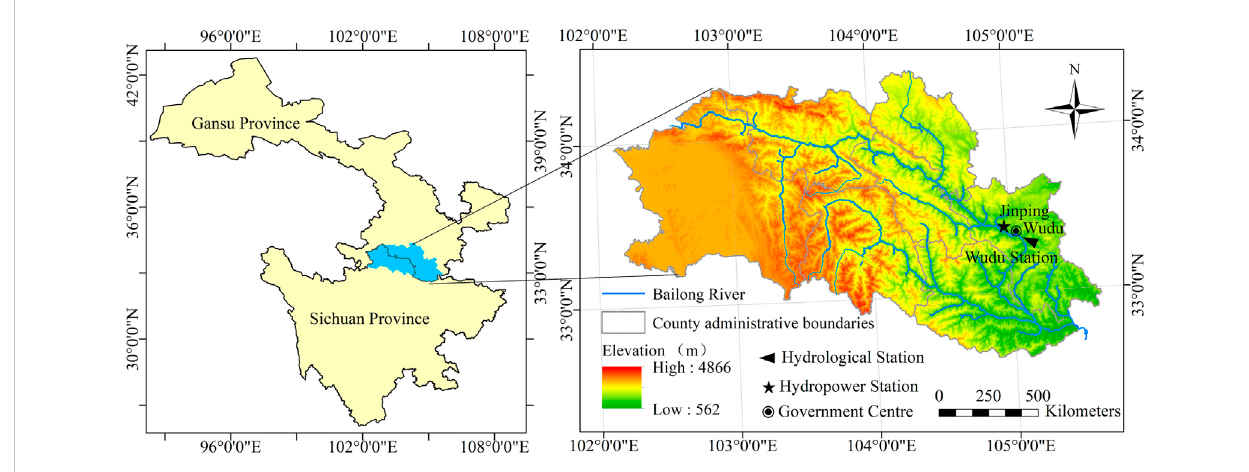
FIGURE 1 Overview of the water system and hydrological station distribution in Bailong River Basin, China.